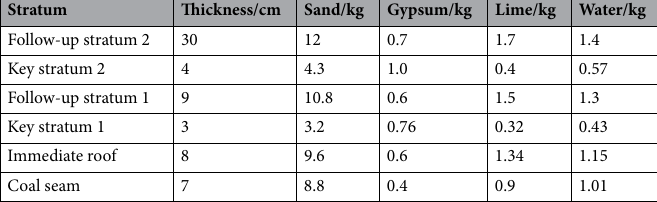
Table 1. Materials ratio.